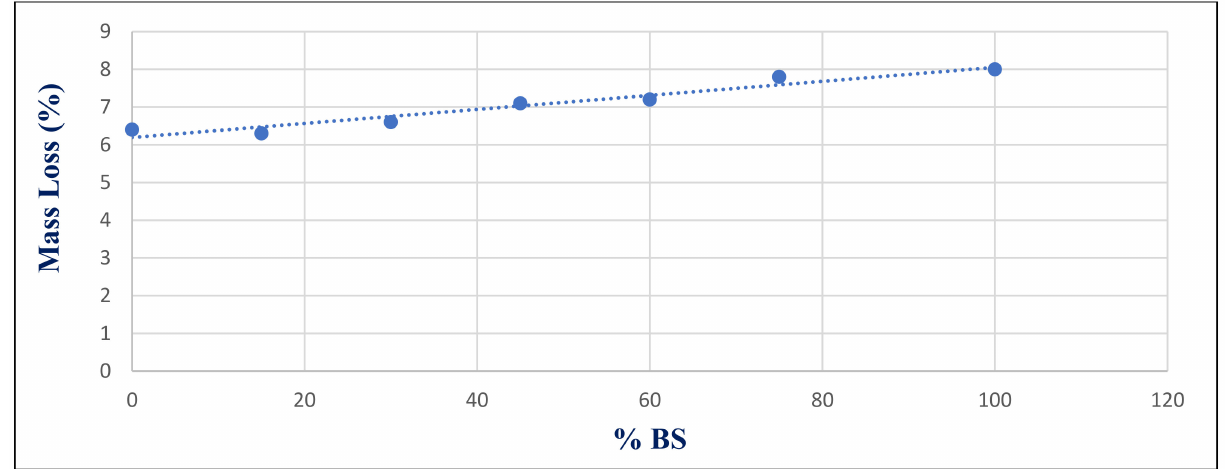
Figure 31. Correlation relation between %BS and %Mass loss at 750 o C for group Z at day 180.